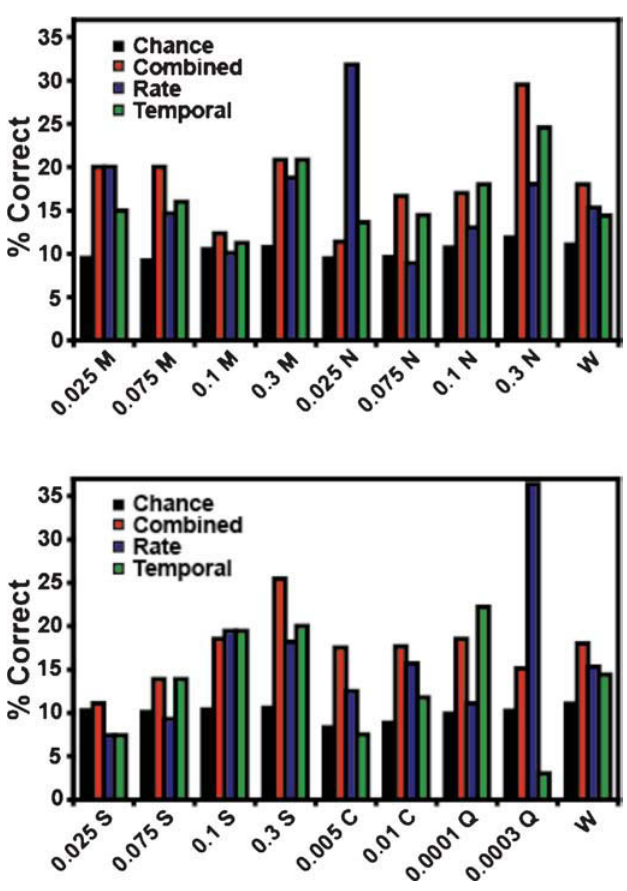
Figure 5. Tastant predictions for the reinforced lick data. This figure presents the percentage of correctly identified trials for each tastant con- centration. The coloring conventions are the same as in Figure 3 . The top graph depicts the predictions for MSG (M) and NaCl (N) at 0.025, 0.075, 0.1, and 0.3M. The bottom graph depicts the predictions for sucrose (S, at 0.025, 0.075, 0.1, and 0.3M), citric acid (C, at 0.005 and 0.01M), and quinine (Q, at 0.0001 and 0.0003M). Water (W) is repeated in both graphs for comparison with the other stimuli. Of the three model types, only the combined model correctly identified all 17 stimuli above the weighted chance levels.